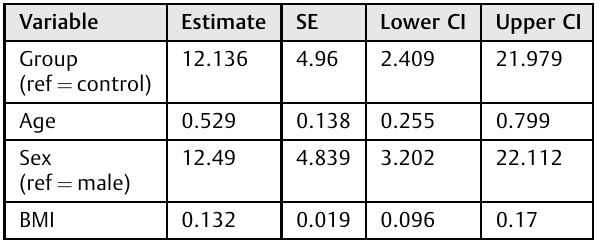
Table 3 Bayesian path analysis output to investigate the effect of intervention variables, age, gender, and BMI on